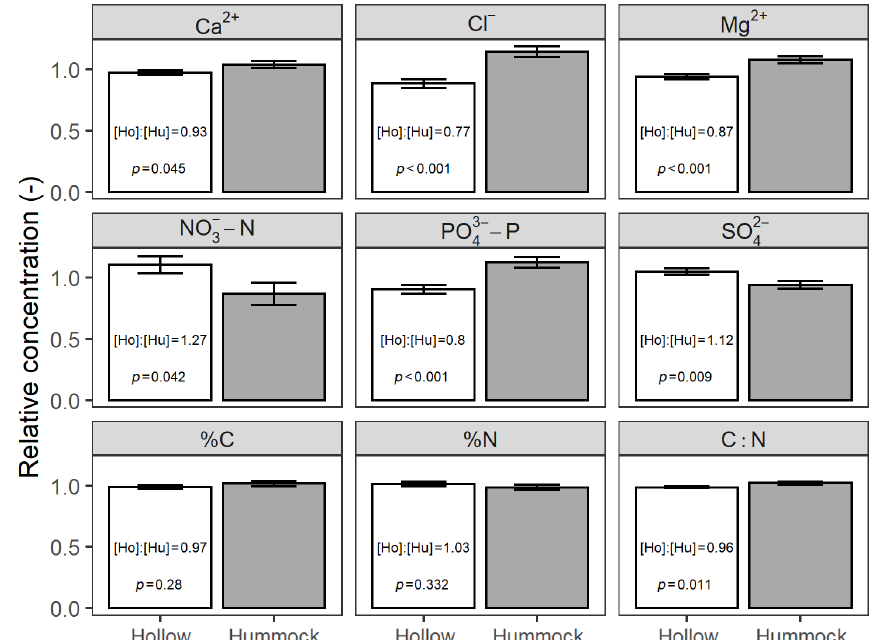
Figure 6. Across-site comparison between hummocks and hollows of relative concentrations of soil analytes. Relative concentration for any particular sample is normalized to its site-average concentration. Text in each panel refers to the across-site ratio of hollow-to-hummock relative concentrations and the Welch’s two-sample t test of hollow and hummock